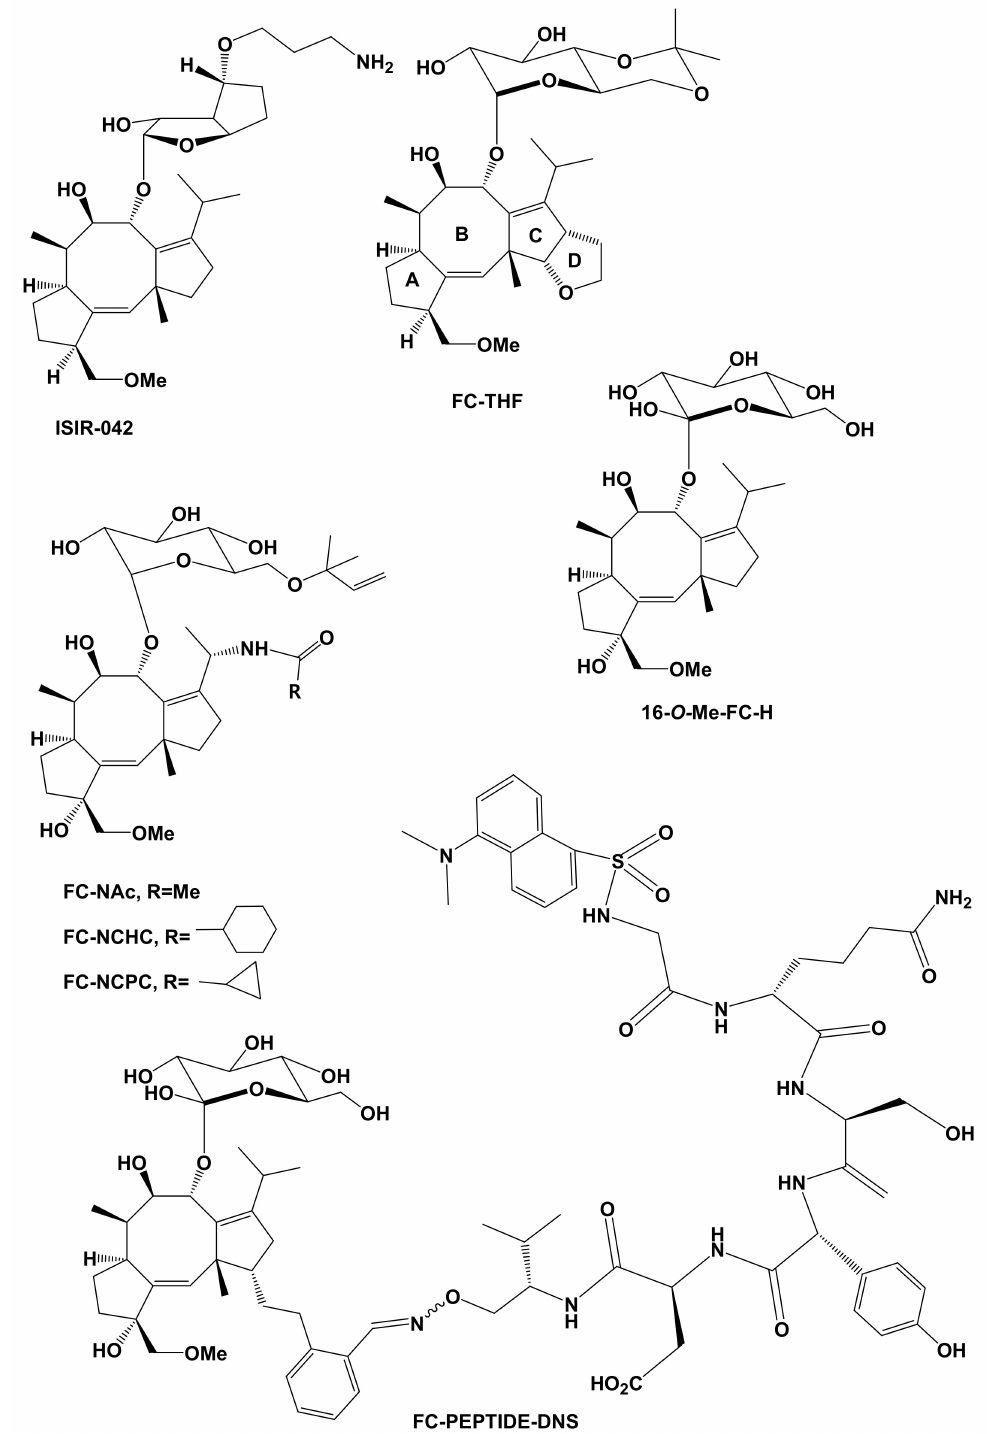
Figure 11. Semisynthetic FC derivatives for pharmacological